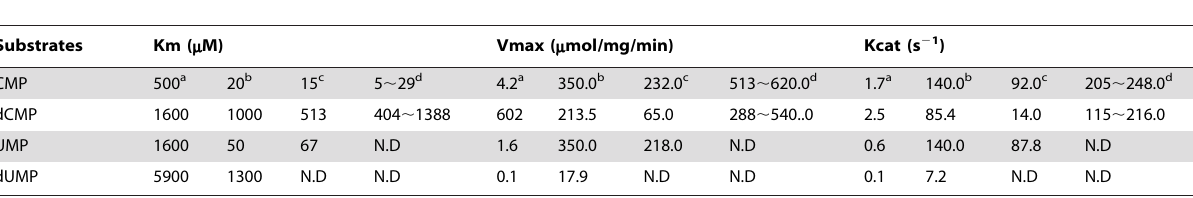
Table 1. Kinetic properties of recombinant human UMP/CMPK with ATP as phosphate donor.